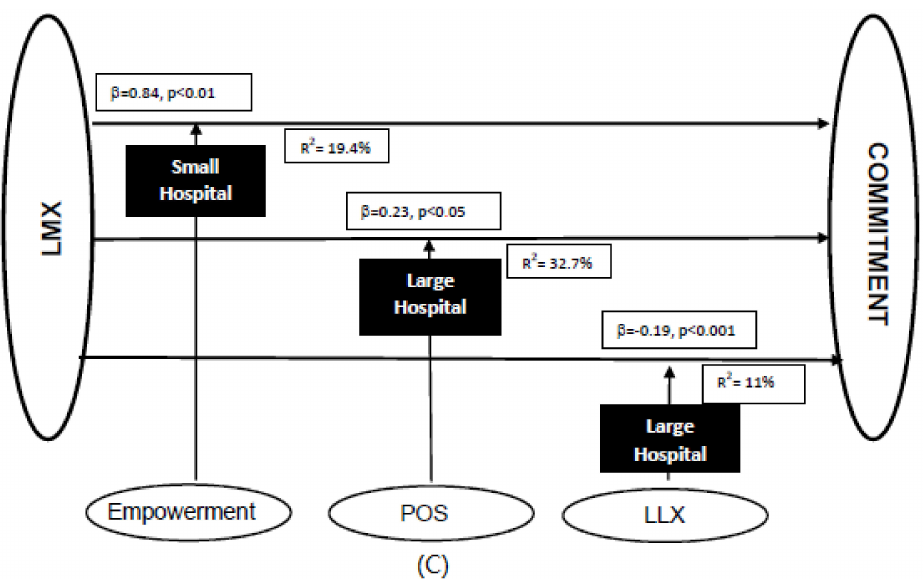
Figure 2. The hypothesised model with standardised parameters. ( A ): The moderating e ff ect of the variables: Empowerment, perceived organisational support (POS), and leader–leader exchange (LLX) on the LMX-commitment relationship (dotted line indicates no e ff ect). ( B and C ): The influence of sex and hospital size on the moderation of the variables in the LMX-commitment relationship. In B and C, only statistically significant associations are